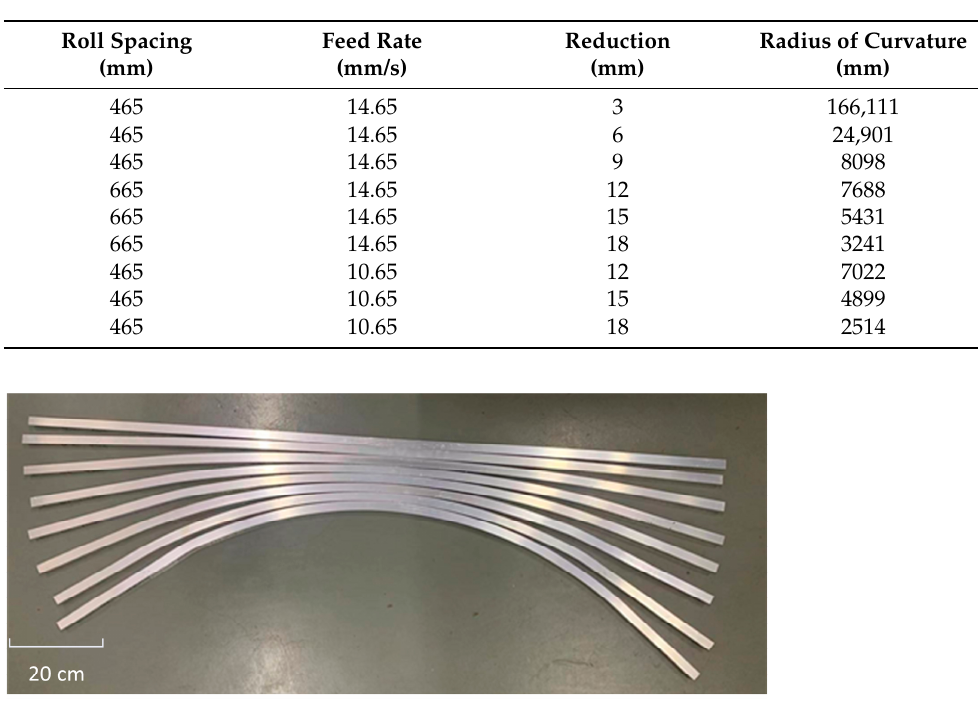
Table 5. Part of the dataset.